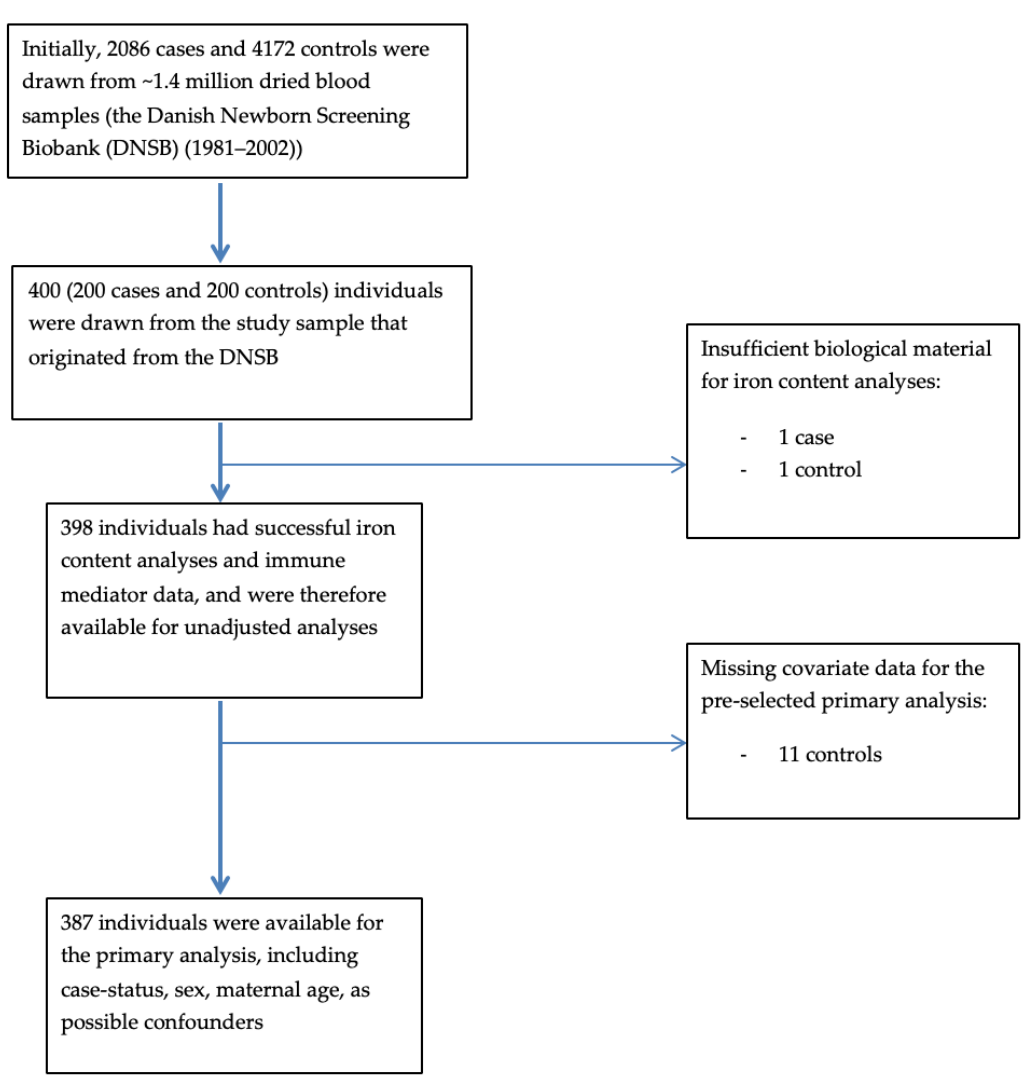
Figure 1. Flow chart of participants included in the study and different models.